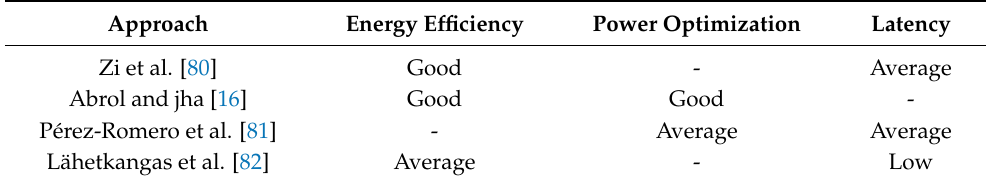
Table 11. Summary of Optimization Based Approaches in 5G Technology.